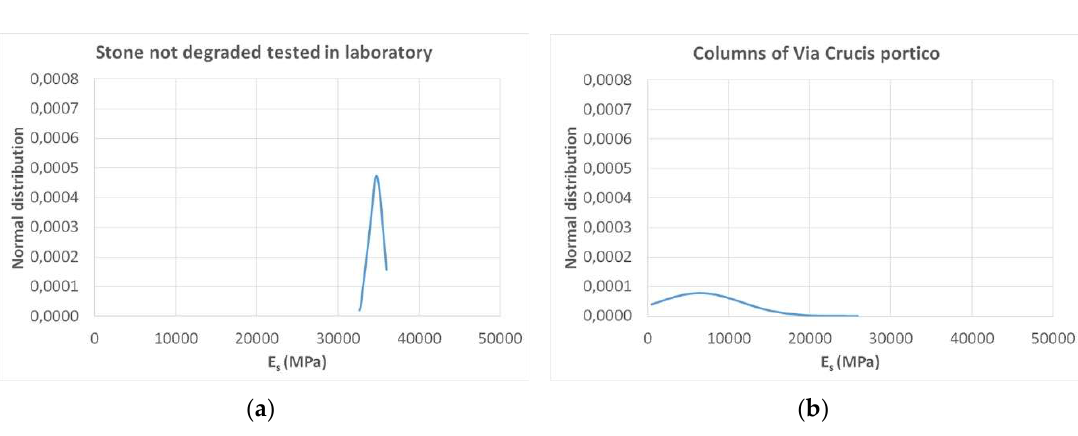
Table 2. Impact tests on new and old granitic stones.